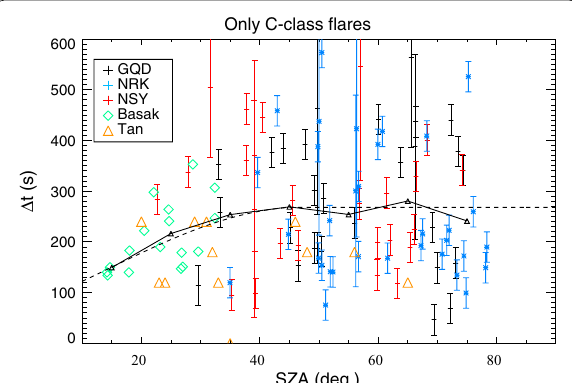
Fig. 4 Time delay as a function of the Solar Zenith Angle. The black triangles represent the average values within bins of 10 ◦ and the dashed line is a fit of those